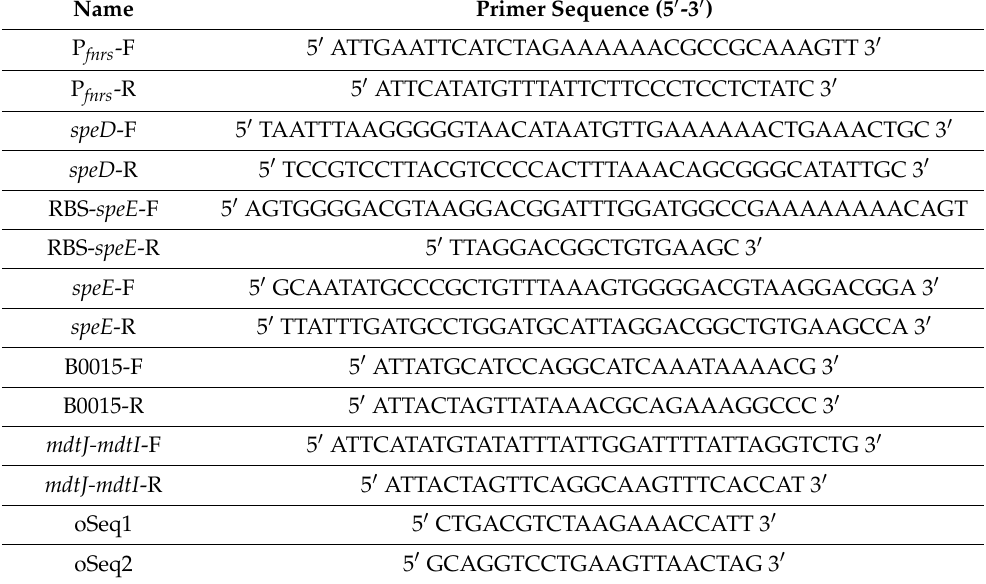
Table 1. Primers used in this study. speE (spermidine synthase) and speD (S-adenosylmethionine synthase). mdtJ and mdtI genes code for the spermidine export proteins